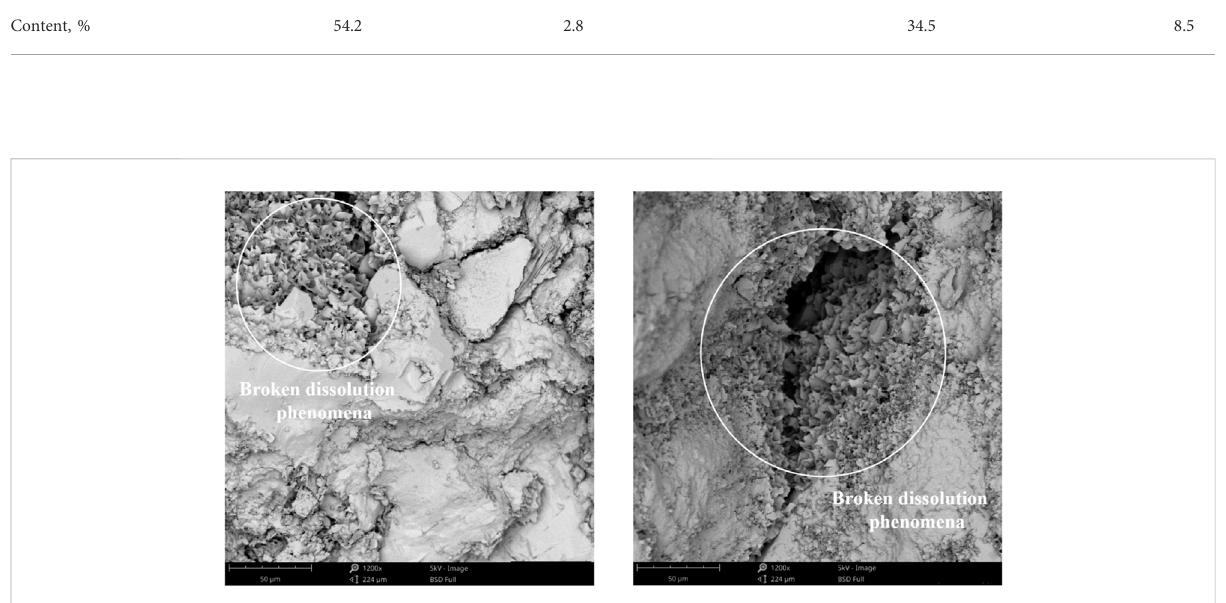
FIGURE 11 Effect of supercritical CO 2 on microstructure of tight sandstone (After 360